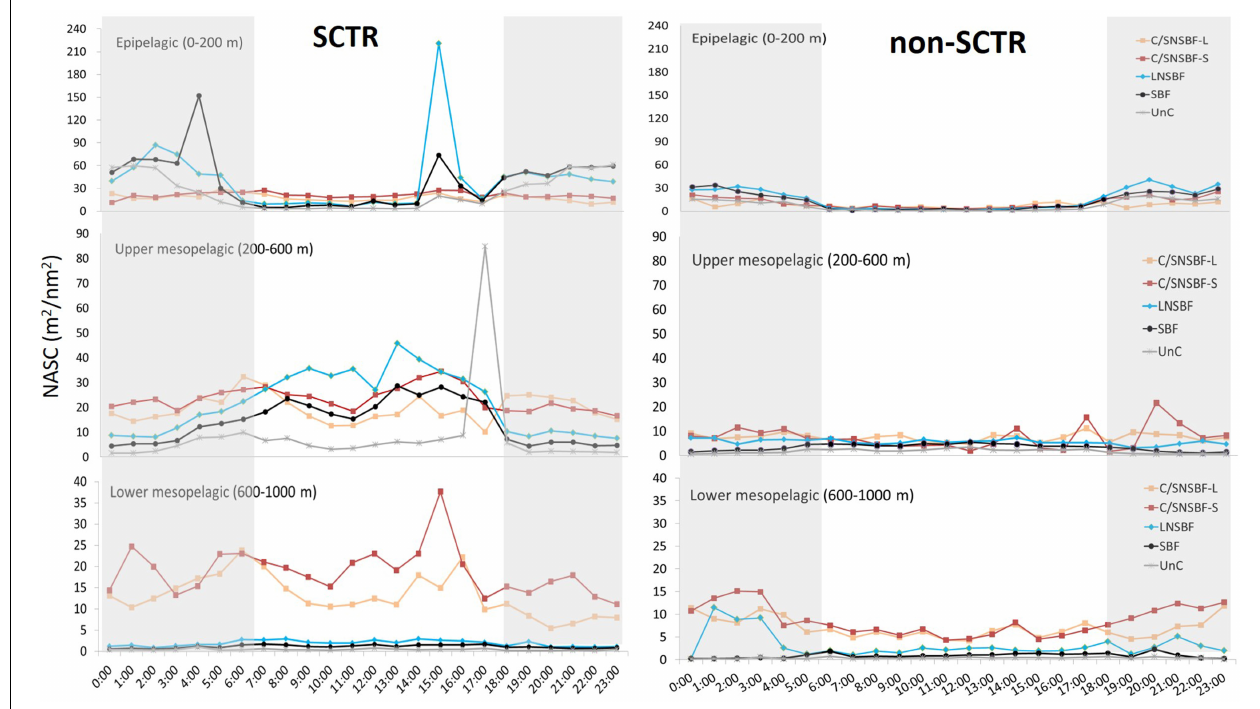
of 60 ◦ E and 67 ◦ E, respectively, are presented in Figure 7 .